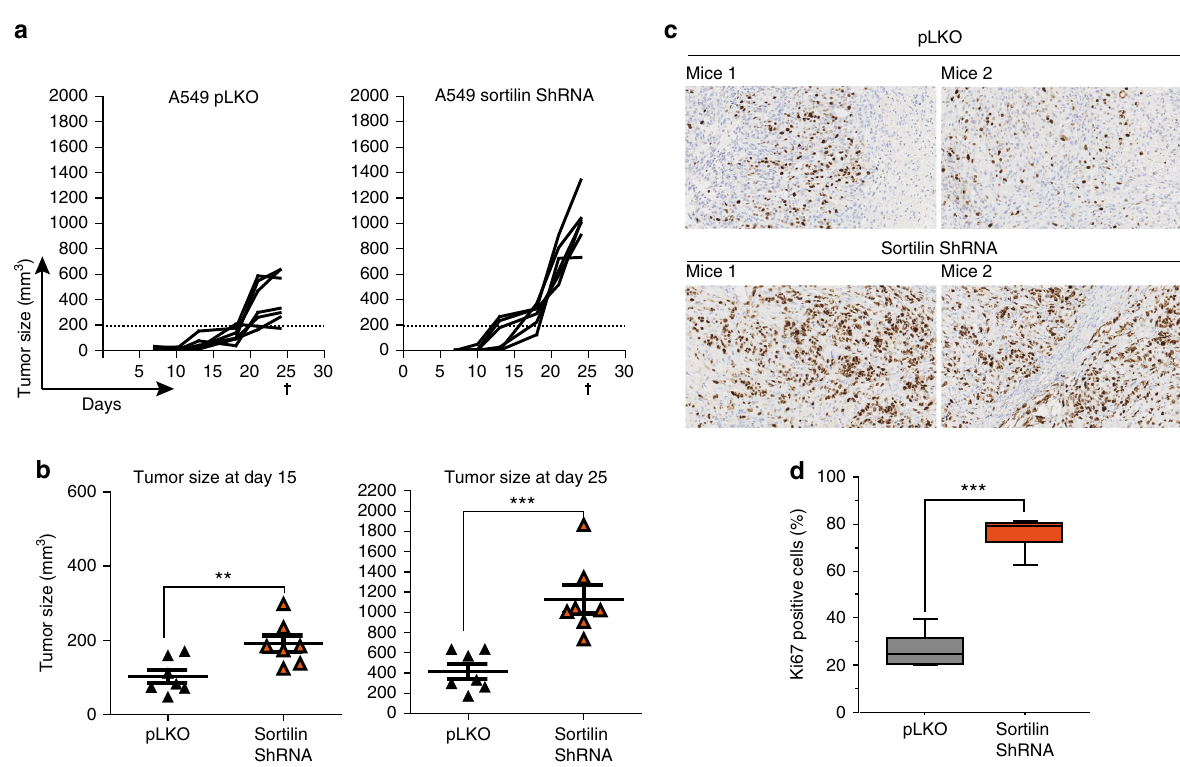
Fig. 5 Sortilin depletion dramatically accelerates tumor growth in vivo. a Tumor growth curves showing evolution of the tumor volume after engraftment of 1 × 10 6 sortilin-depleted or control A549 cells (pLKO). b Grouped column scatter shows the mean difference tumor volume between sortilin-depleted and control cells, 15 and 25 days after engraftment. c 25 days after engraftment, all mice were killed, and tumors were excised and subjected to immunohistochemical analysis. Tumors from sortilin-depleted or control A549 cells were stained using anti-Ki-67 antibody. Percentages of Ki-67-positive cells are quanti fi ed in d . All values represent means ± SD, Student ’ s t -test ** P < 0.01, *** P < 0.001. Each experiment has been repeated at least three